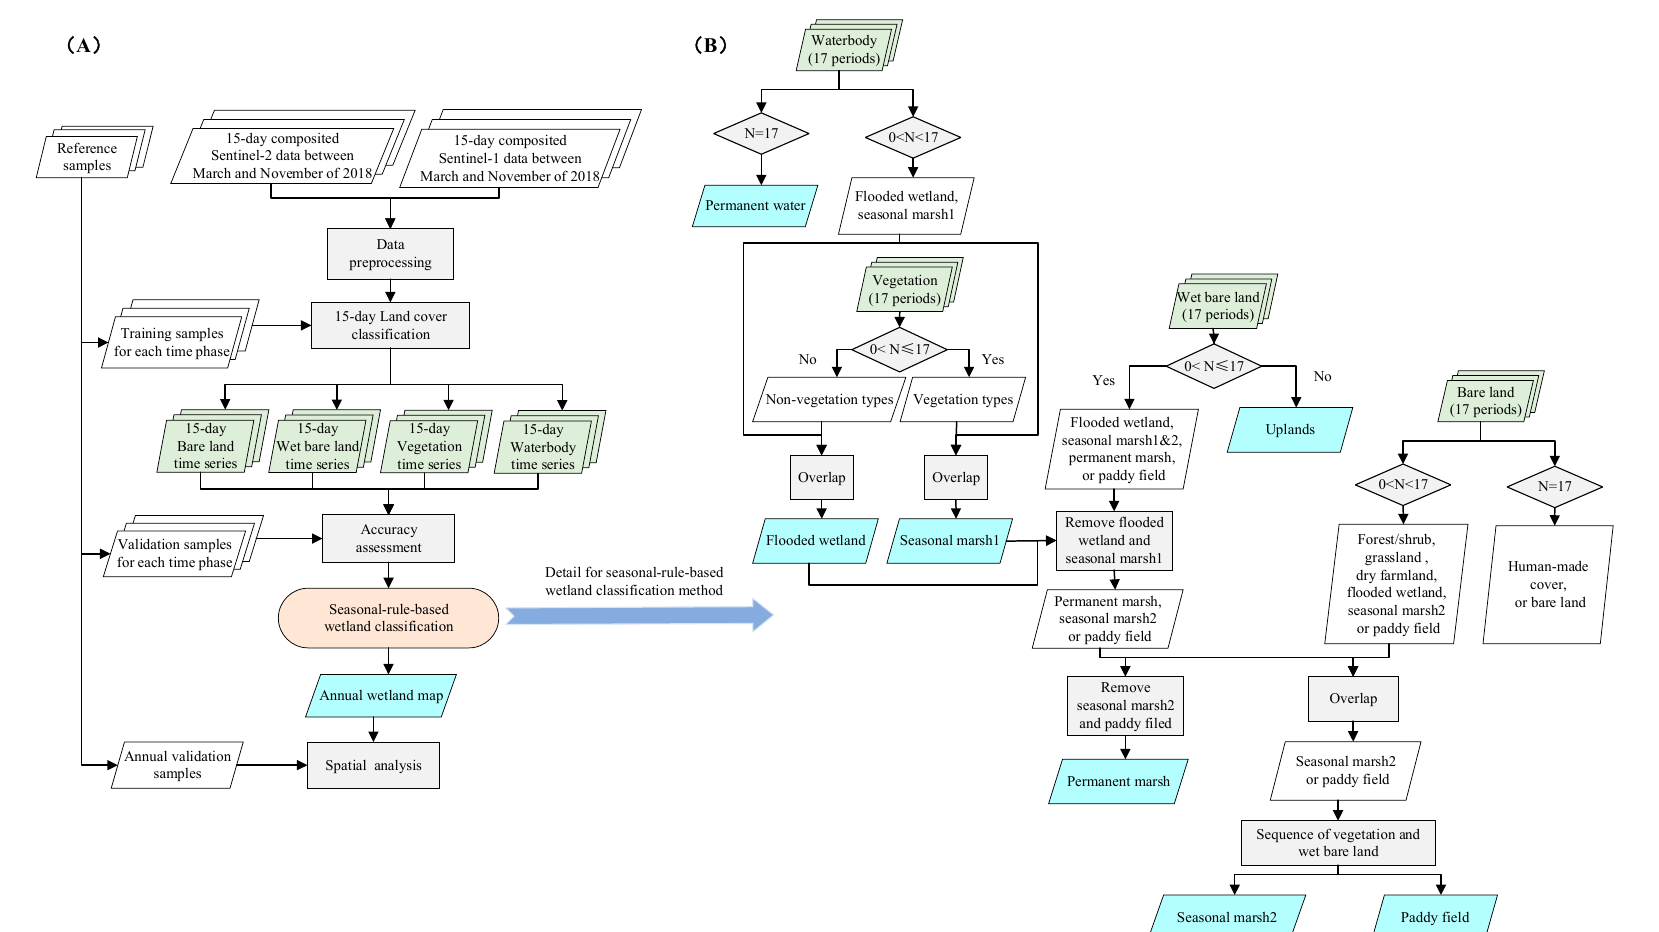
Figure 3. Flowchart of the methodology followed in the study ( A , B ). N is the number of 15-day periods, with a maximum value of 17.